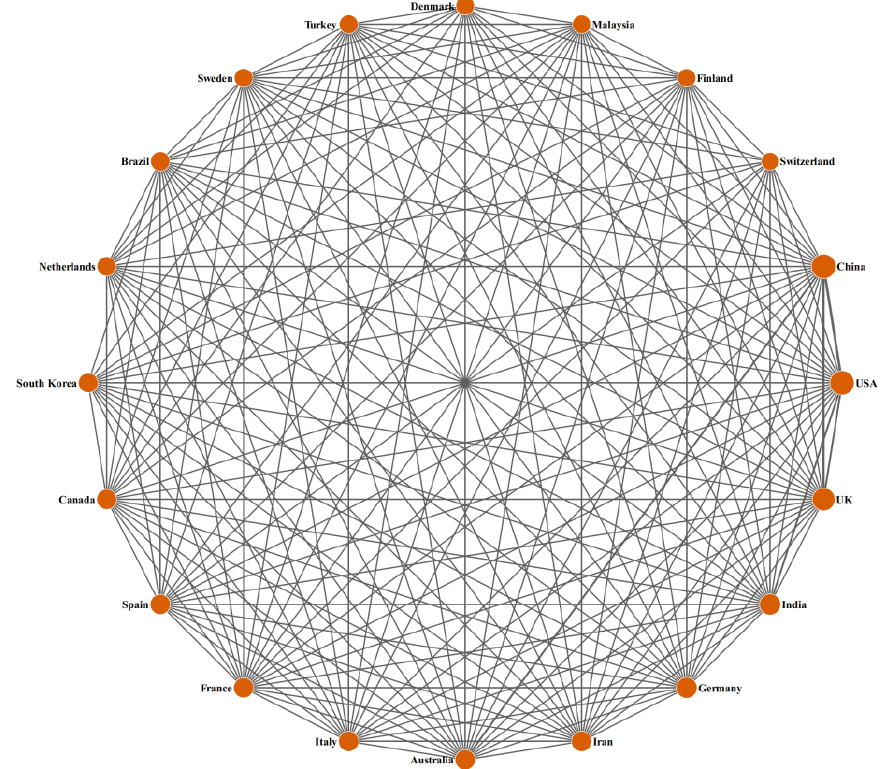
Figure 5. Collaboration matrix map among the top 20 most productive countries/regions.